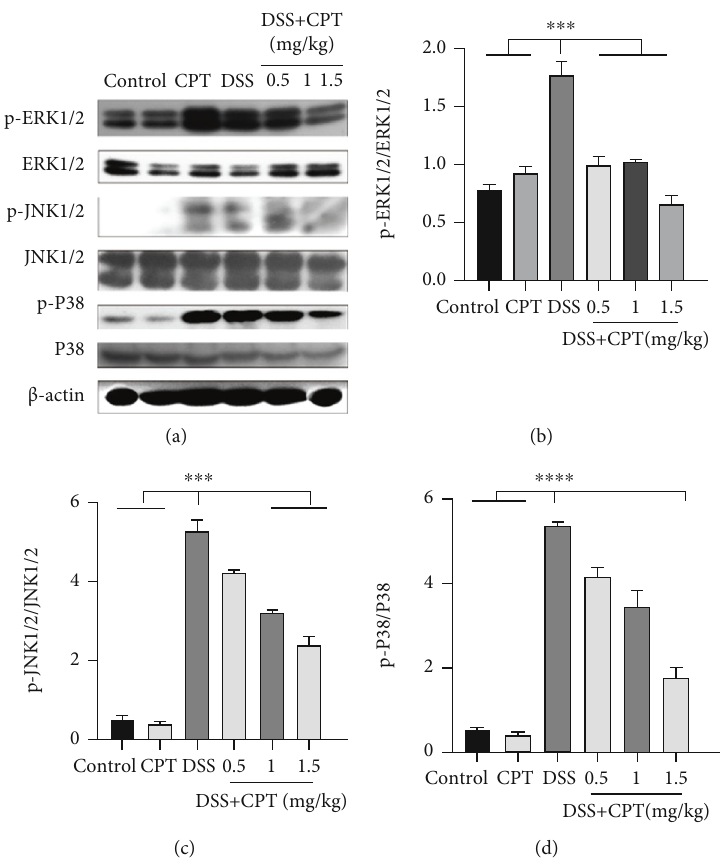
Figure 4: E ff ects of camptothecin (CPT) on the MAPK signaling pathway in DSS-induced ulcerative colitis in mice. Tissue lysates were prepared and subjected to western blot using (a, b) p-ERK1/2, (a, c) p-JNK1/2, and (a, d) p-P38 antibodies. The p-ERK1/2, p-JNK1/2, and p-P38 immunoreactive bands were digitized and expressed as a ratio of ERK1/2, JNK1/2, and P38 levels (b – d). Values are presented as mean ± SD ( ∗∗∗∗ P < 0 : 0001 vs. the DSS